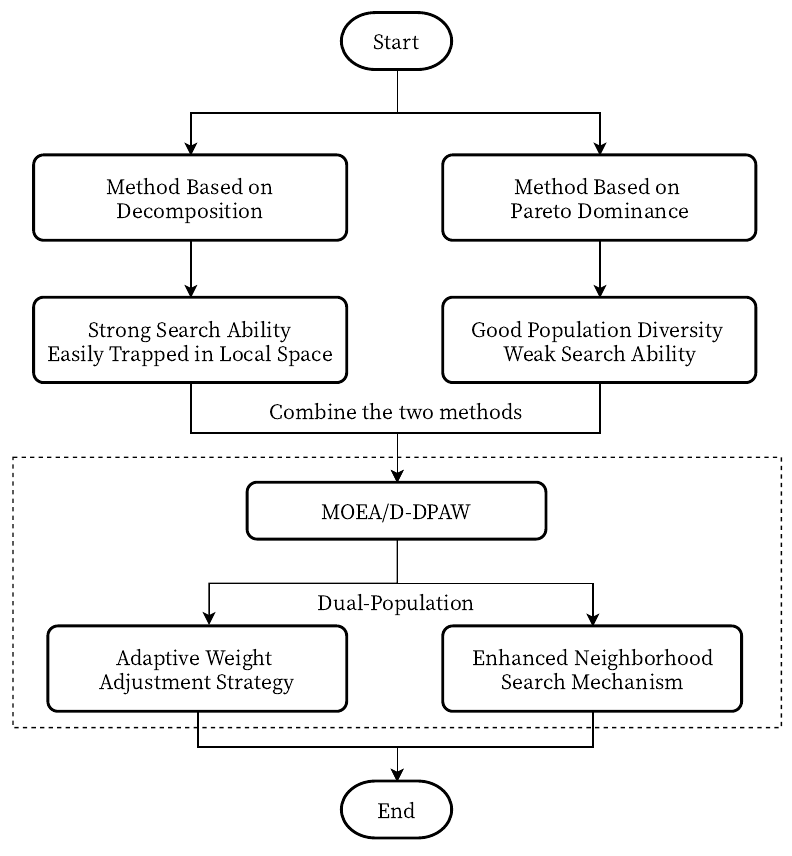
Figure 1. Research Roadmap of the Proposed Algorithm